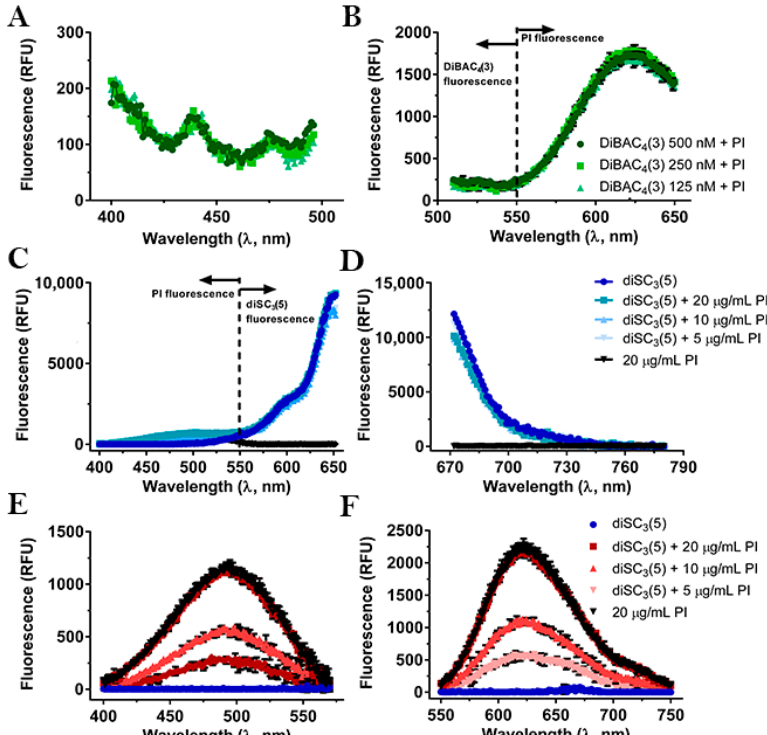
Figure 1. Fluorescence excitation ( A ) and emission ( B ) spectra of bis-(1,3-dibutylbarbituric acid)trimethine oxonol (DiBAC 4 (3)) + Propidium Iodide (PI) and fluorescence excitation ( C,E ) and emission ( D,F ) spectra of 3,3’-dipropylthiadicarbocyanine iodide (diSC 3 (5)) +/ − PI. ( A ) Excitation spectra with 516 nm detection wavelength (DiBAC 4 (3) emission maximum); ( B ) emission spectra with 496 nm excitation wavelength (DiBAC 4 (3) excitation maximum) of three di ff erent DiBAC 4 (3) concentrations + 10 µ g / mL PI; ( C,E ) excitation spectra with 672 nm (diSC 3 (5) emission maximum) and 617 nm (PI emission maximum) detection wavelengths, respectively, and ( D,F ) emission spectra with 652 nm (diSC 3 (5) excitation maximum) and 490 nm (PI excitation maximum) excitation wavelengths, respectively, of 400 nM diSC 3 (5) + 20, 10, and 5 µ g / mL PI. For technical reasons due to instrument settings, spectra in ( A – D ) could not be measured at wavelengths > 496 nm, < 510 nm, > 650 nm, and < 670 nm, respectively. In ( A ), ( C ), and ( D ) error bars were omitted for